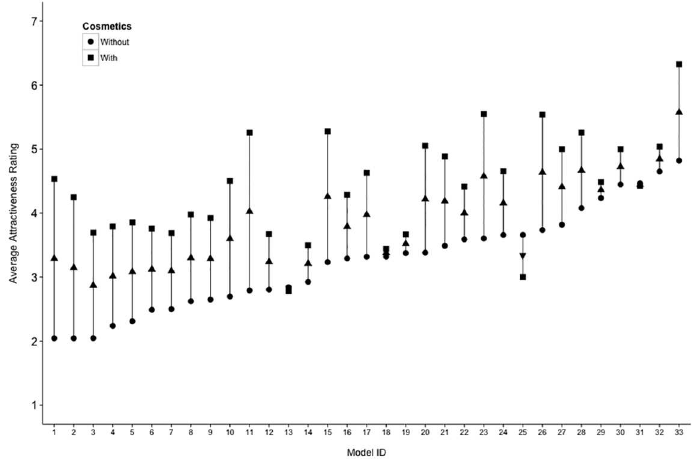
Fig 2. An illustration of the average attractiveness (combining ratings made by men and women) of each model, both without cosmetics and with cosmetics. Models are ordered in terms of increasing attractiveness without cosmetics. An upward pointingarrow indicates an increase in attractiveness with cosmetics, while a downwardarrow indicatesa